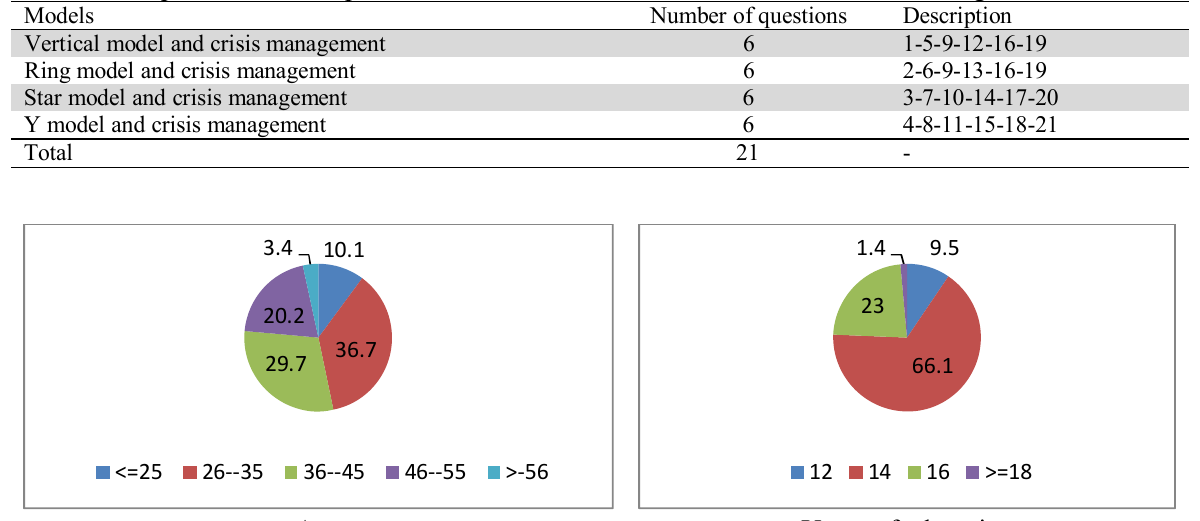
Fig. 2. Personal characteristics of the participants in terms of percent